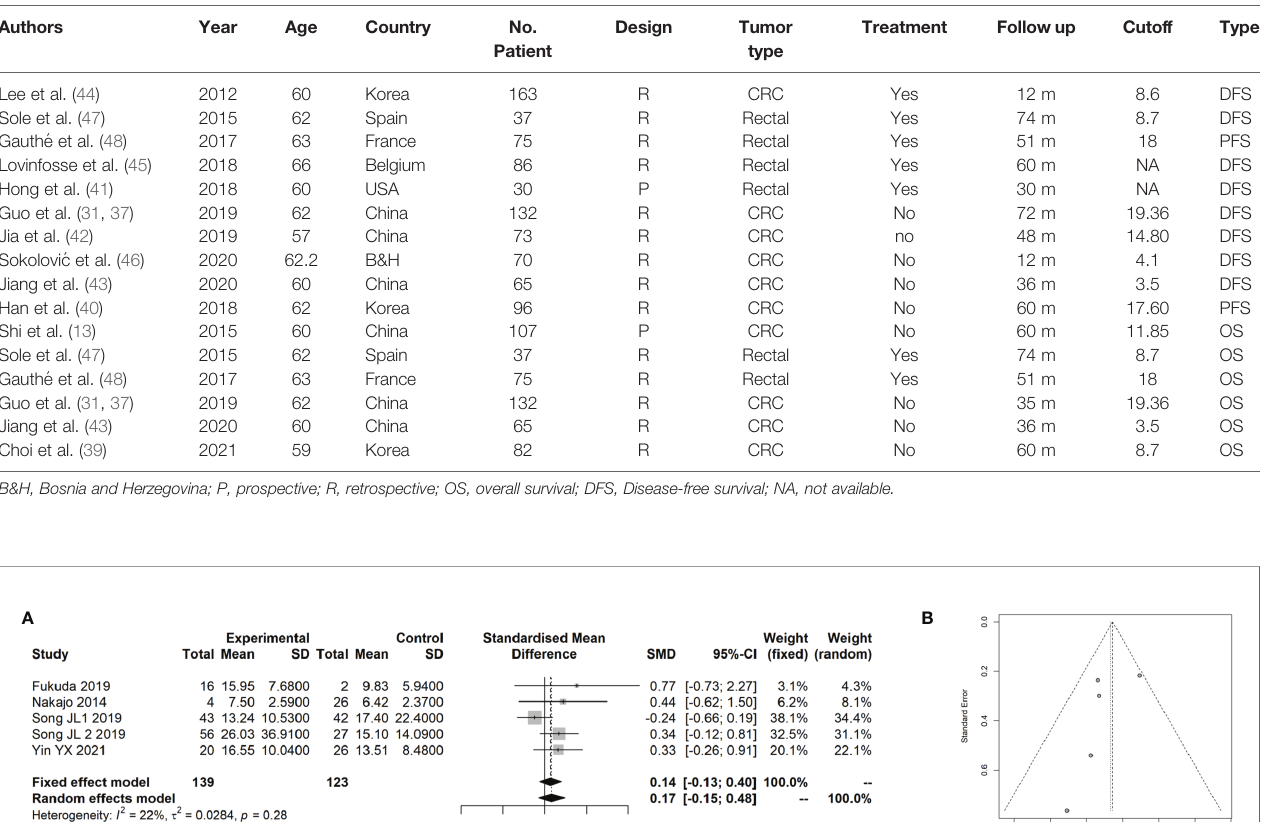
TABLE 4 | Characteristics of studies analyzed the prognosis of SUVmax in colorectal cancer.